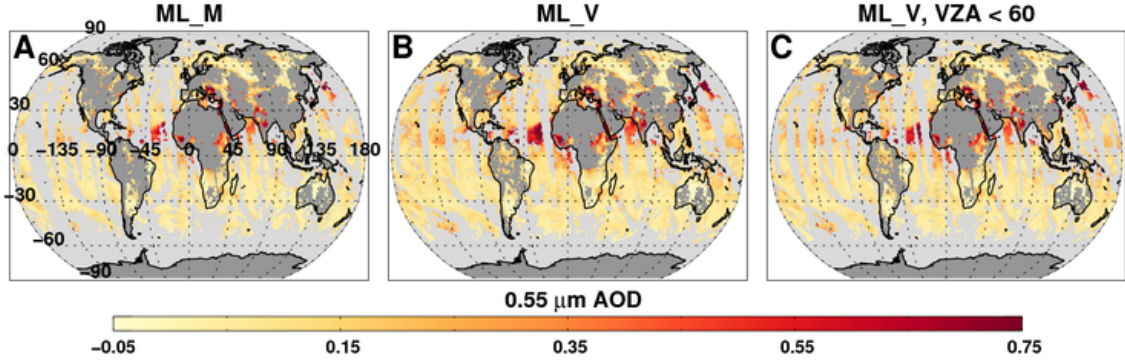
Figure 7. AOD at 0.55µm, retrieved using MODIS-like algorithm on MODIS (a) and VIIRS (b) , created from all orbits during 29 May 2013 (see Fig. 1). (c) approximates the MODIS coverage by reducing the VIIRS swath to sensor view angles less than 60 ◦